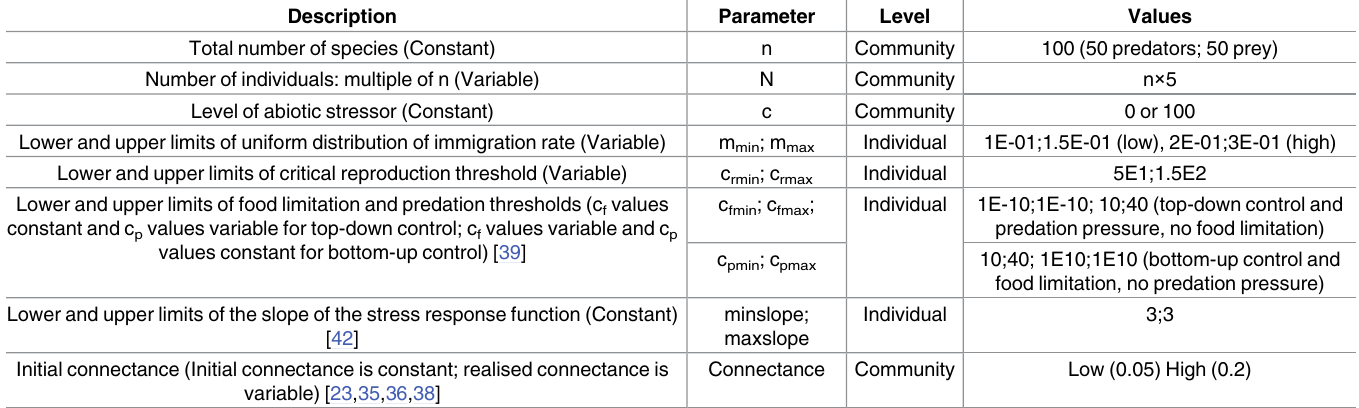
Table 1. Model parameters in their initial